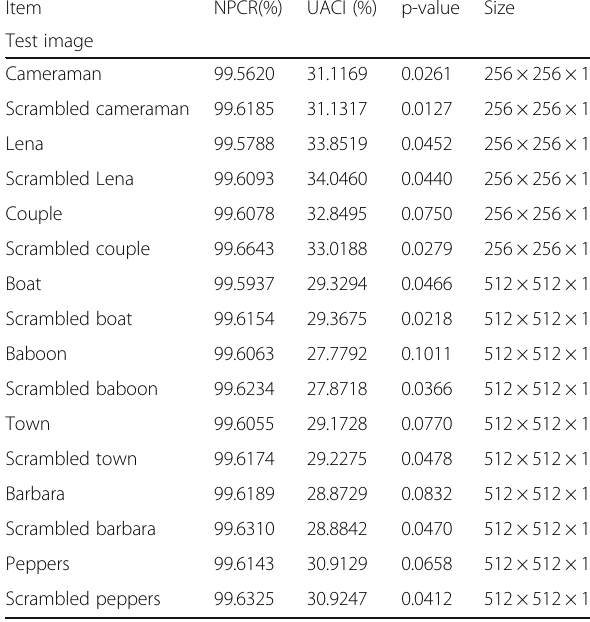
Table 5 NPCR and UACI p values